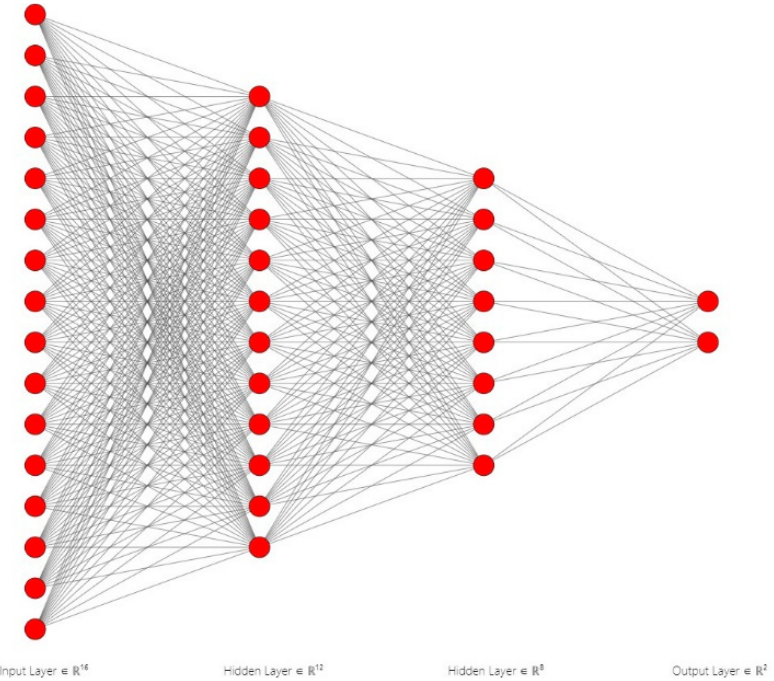
Figure 2. Pictorial depiction of artificial neural network.